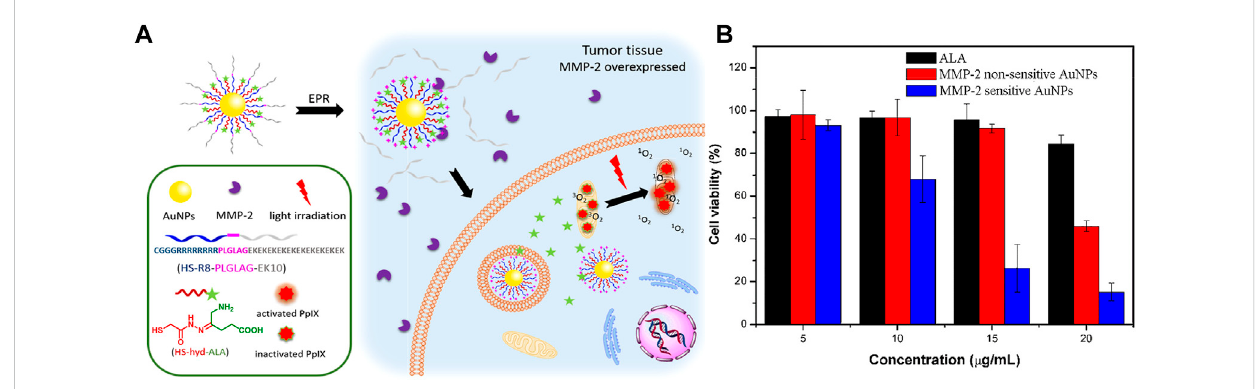
FIGURE 12 (A) . Design and mechanism of pH and MMP-2 dual-responsive AuNPs; (B) . Cell viabilities treated with free ALA, MMP-2-sensitive and MMP-2- nonsensitive AuNPs under light irradiation. Adapted from ref. (Wu et al., 2017b). Copyright 2017 American Chemical Society.